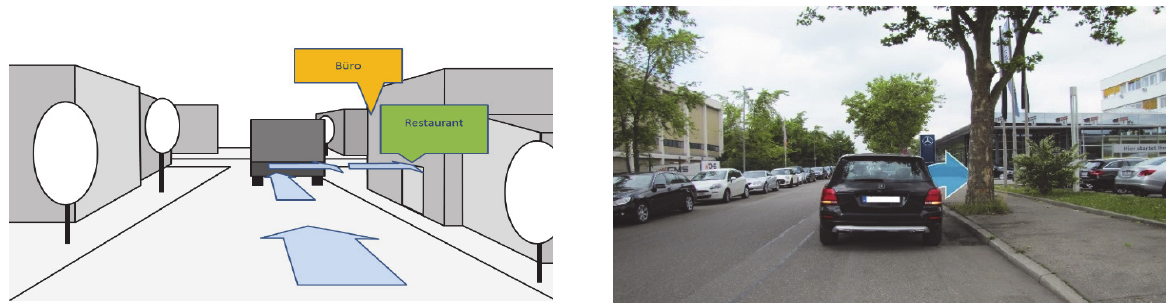
Fig. 5 Available augmented reality systems typically superimpose the augmentation to the image, without considering the distance. The inconsistent depth information can be misleading (left, augmentation colored). Three dimensional fusion is possible with depth data and leads to an even more consistent augmentation